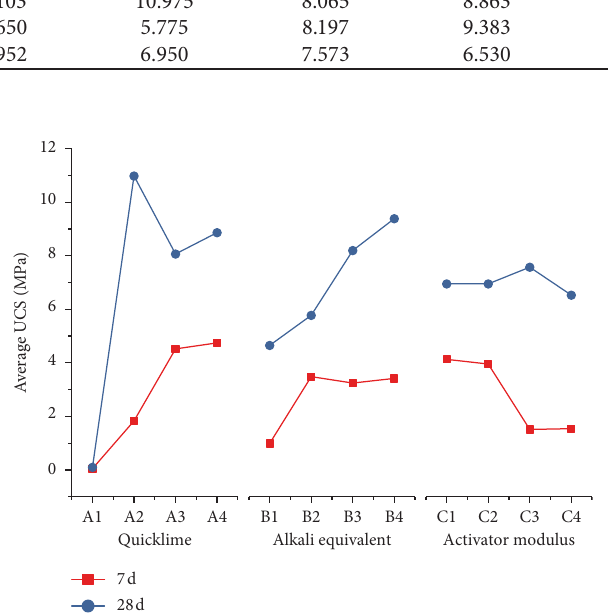
Figure 6: Trend chart of the average UCS VS factor level. Table 5: Range analysis of rheological